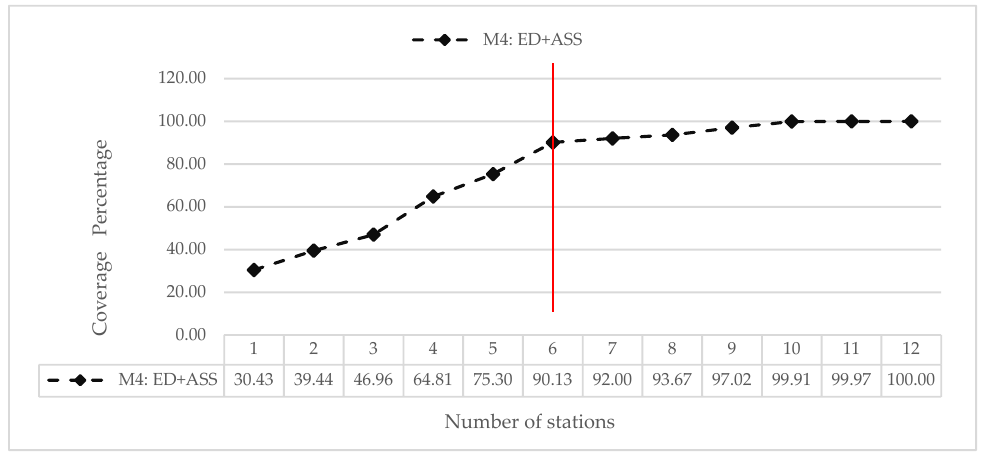
Figure 8. Plot of coverage percentage versus number of stations in Bangkok.